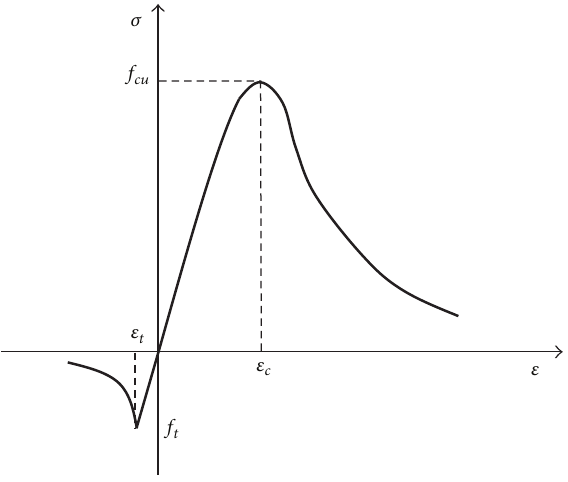
Figure 3: Uniaxial stress-strain curve of